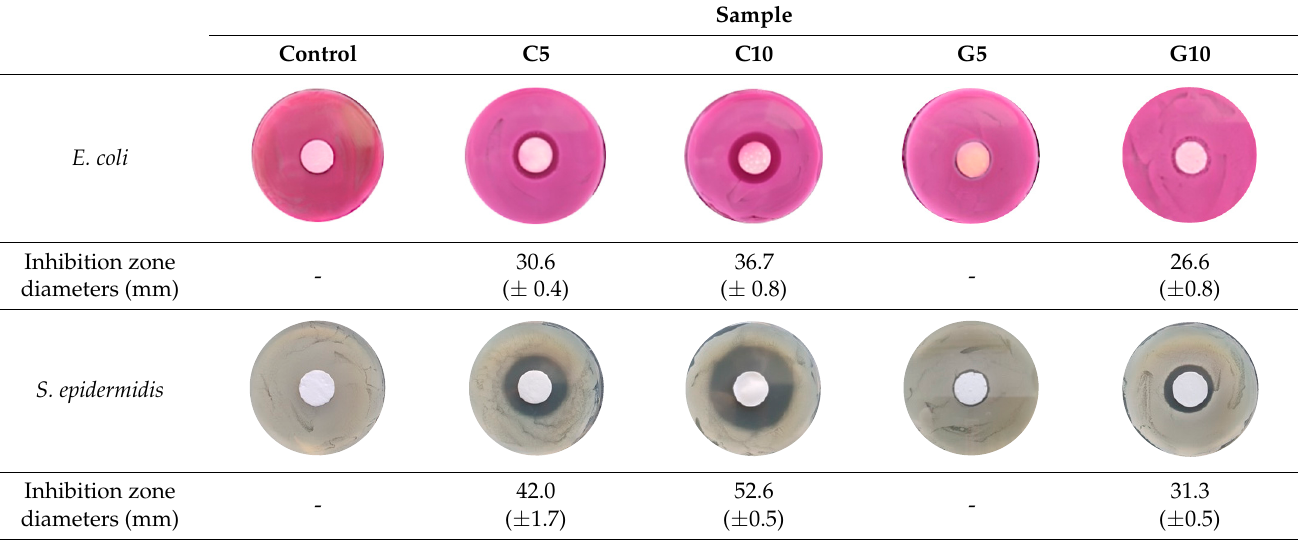
Table 3. Inhibition zones of the electrospun webs against two bacteria strains: E. coli and S. epidermidis .